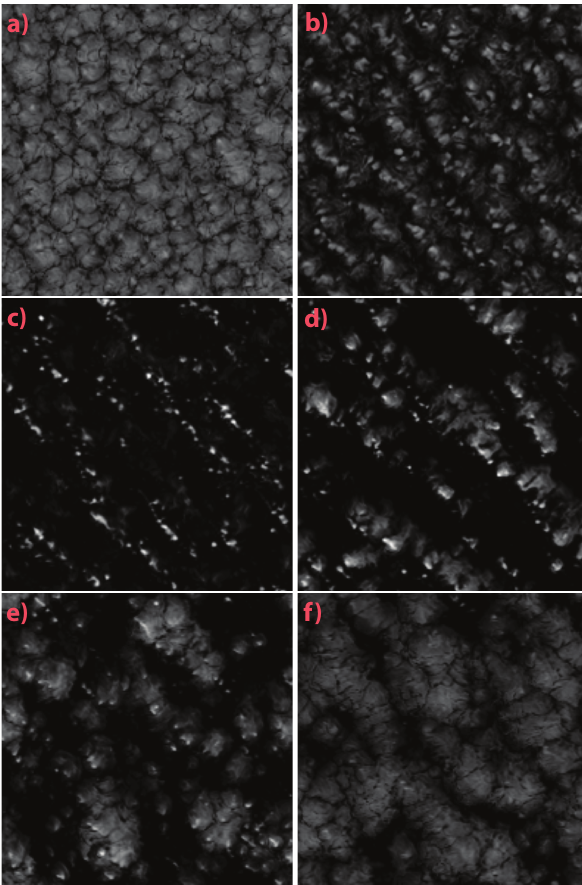
Figure 3. Time series of (a) LWP, (b) rain water path (RWP), (c) do- main mean surface rain rate R sfc , and (d) surface rain rate condi- tionally sampled for R ≥ 0.1mmd − 1 ( R cond ) for the control case and for the various minimum N as in Fig. 1. Recovery becomes progressively more difficult with decreasing minimum N . The ini- tial spike in surface R cond is related to the fact that during the first hour of simulation, collision–coalescence and sedimentation are not